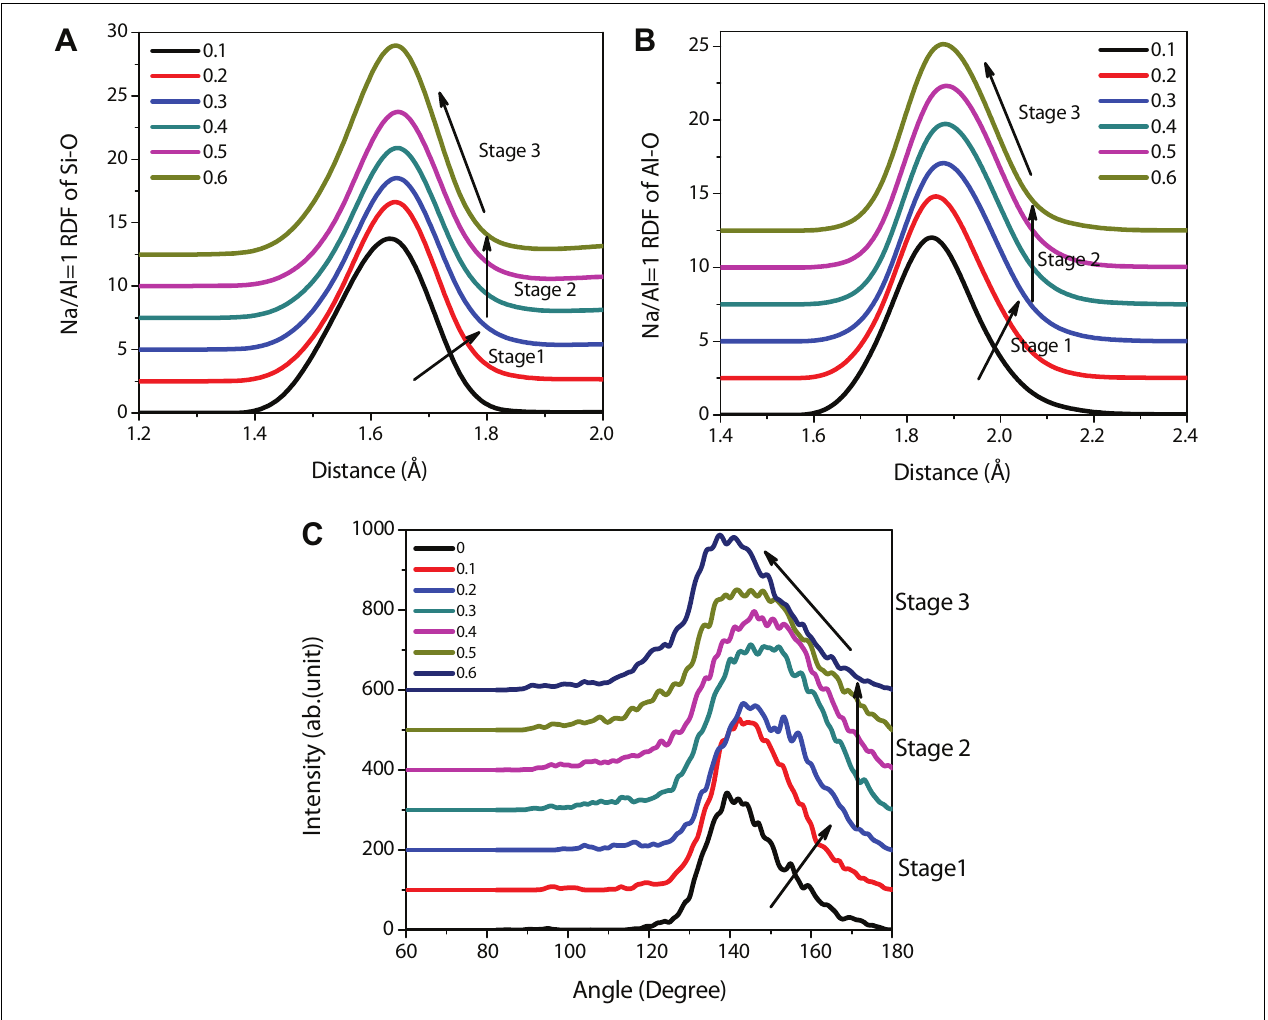
FIGURE 6 | Evolution of RDF for (A) Si-O, (B) Al-O stretched by loading with a rate of 0.08/ps, and (C) Si-O-Si angle distribution as a function of strain for the NASH gel with a Na/Al ratio of 1. Stage 1, 2, and 3 represent the elastic region, yield region, and failure region, respectively.